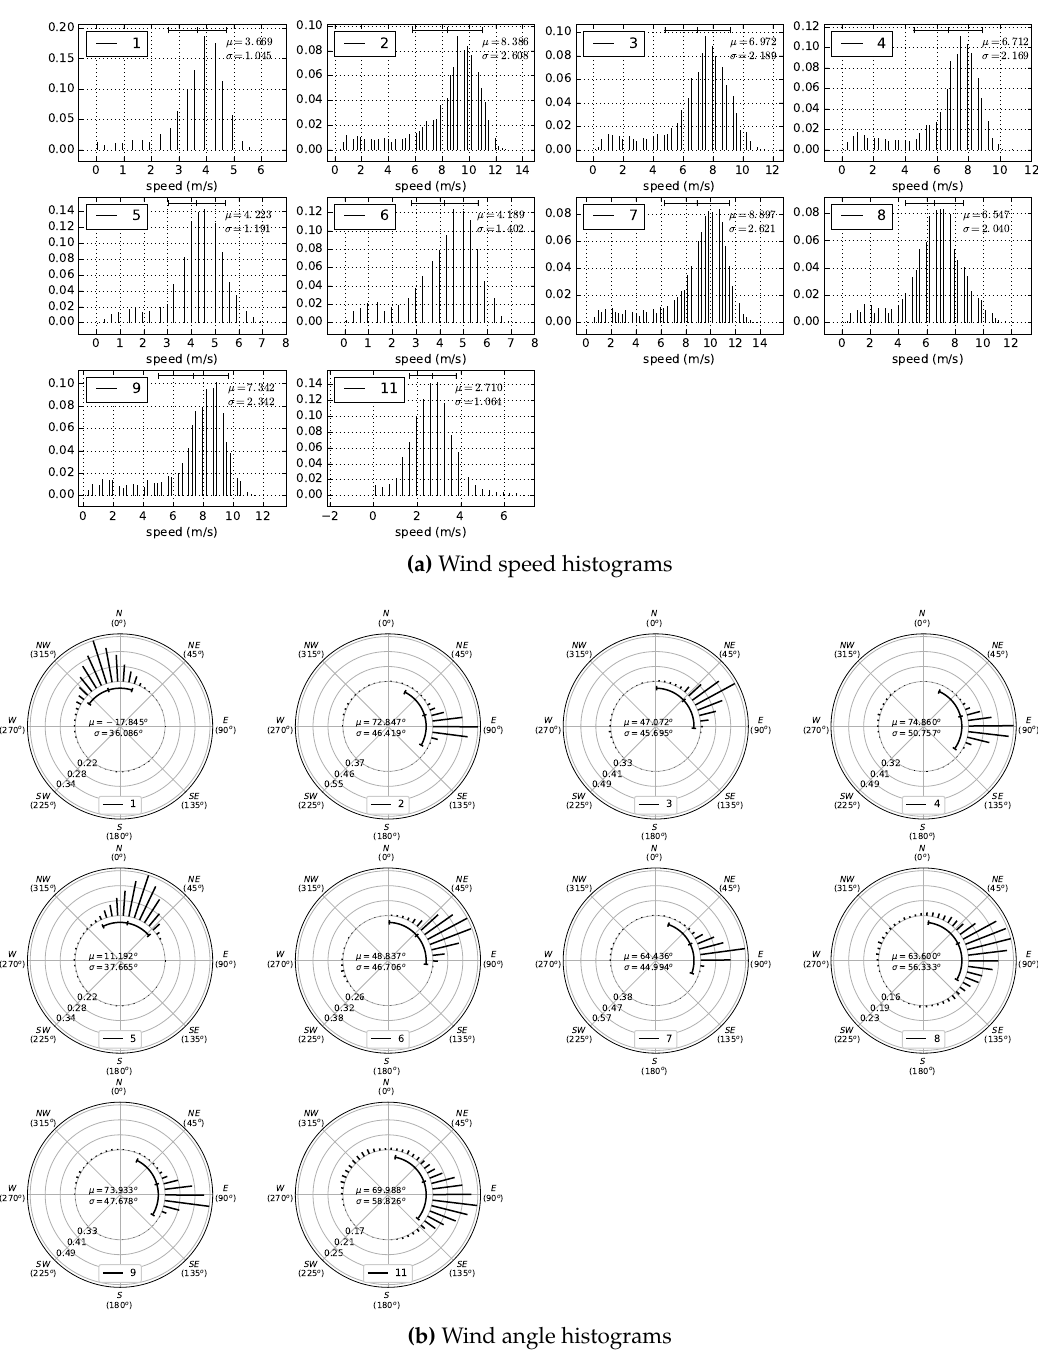
Figure 14. Second data acquisition session. Time period: 1:00 p.m.–4:38 p.m. Ten sensors were used in this experimental session (eleven sensors were used, but sensor 10 malfunctioned during this session and so has been omitted). ( a , b ) show respectively the histograms of wind speed and direction acquired by each sensor during the experiment. Each histogram line represents the fraction of measurements in a discrete interval or bin of speeds and angles respectively. Bins are evenly spaced and have the same